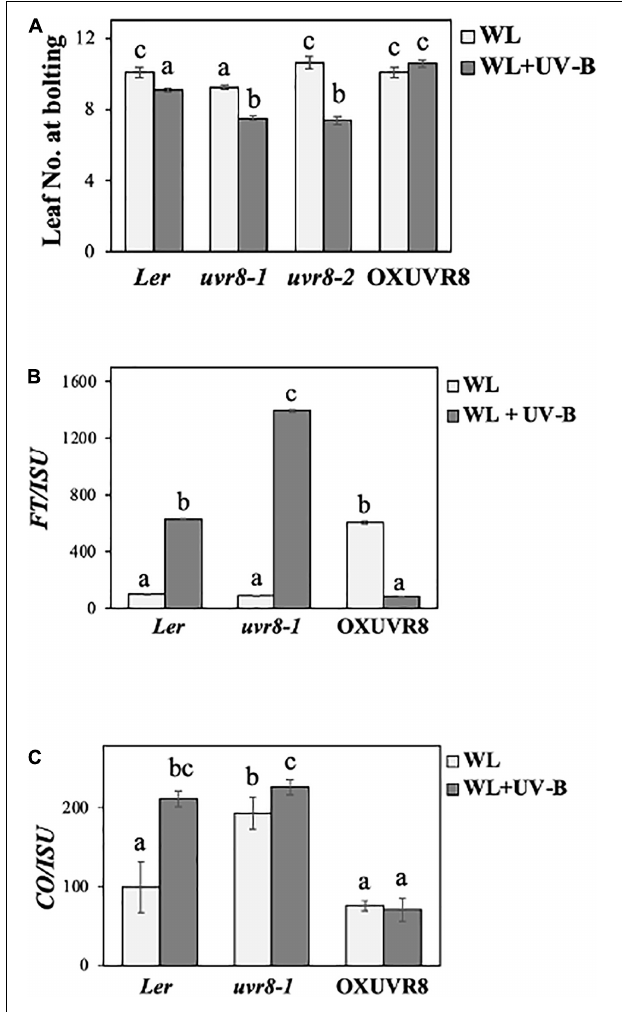
FIGURE 3 | UVR8 acts as a negative regulator of flowering initiation. (A) Flowering time of wild-type ( Ler ), uvr8-1 , uvr8-2, and OX-UVR8 plants grown under a LD photoperiod in WL (50 µ mol m − 2 s − 1 ) or WL supplemented with UV-B (0.5 µ mol m − 2 s − 1 ). Data are represented as mean ± SEM ( n ≥ 15). Different letters indicate statistically significant differences ( P < 0.05) between means. (B,C) qRT-PCR analysis of FT (B) and CO (C) transcript levels normalized with the housekeeping gene ISU in wild-type ( Ler ), uvr8-1 , uvr8-2 and OX-UVR8 plants. Plant tissue was collected at ZT 0.5 12 days after germination. Plants were grown under a LD photoperiod of WL (50 µ mol m − 2 s − 1 ) or WL supplemented with UV-B (0.5 µ mol m − 2 s − 1 ). Plants grown under WL were used as reference (100%). Data are representative of three biological repeats including all genotypes represented above, a minimum number of 15 plants was assayed per genotype. For qPCR experiments for each biological repeat three technical qPCR replicates were conducted.